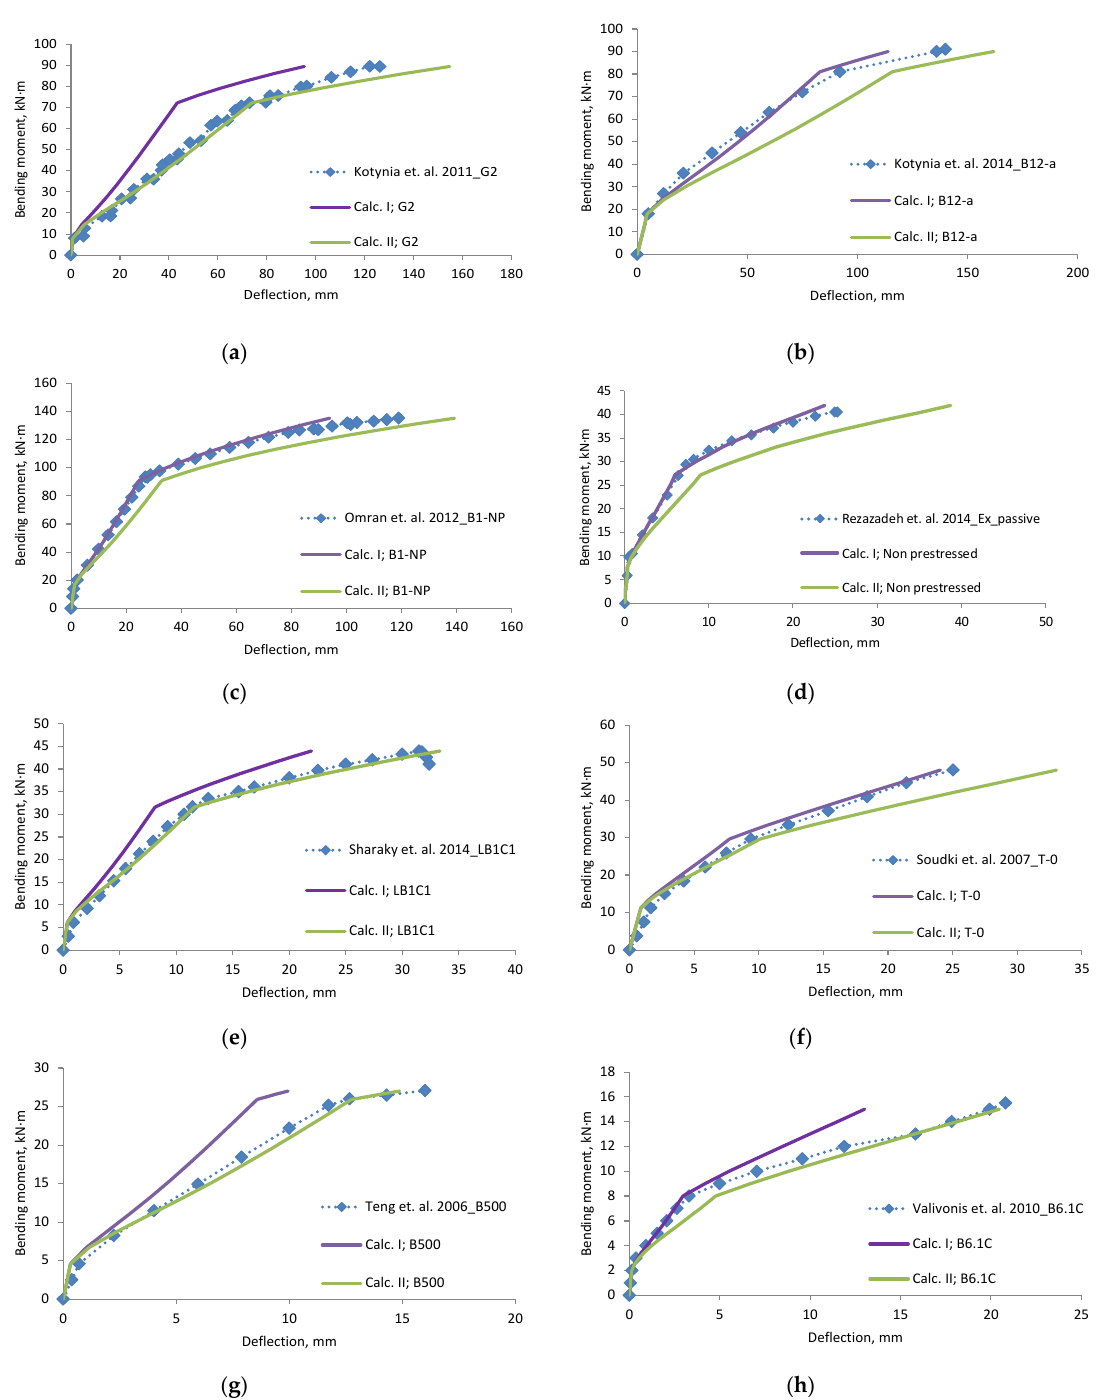
Figure 8. Bending moment–deflection curves, ( a ) beam G2; ( b ) beam B12-a; ( c ) beam B1-NP; ( d ) beam Non prestressed, ( e ) beam LB1C1; ( f ) beam T-0; ( g ) B500; ( h ) B6.1C.